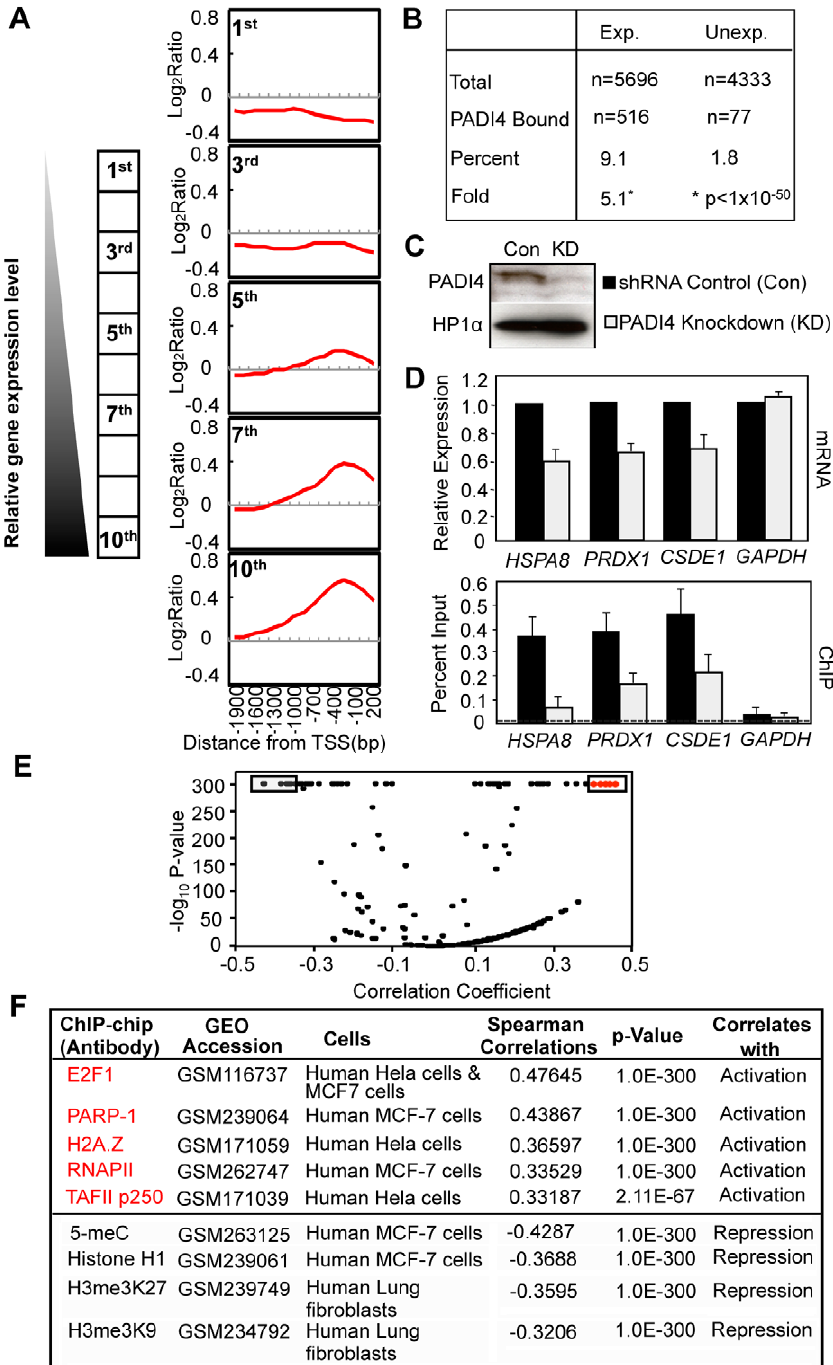
Figure 2. PADI4 recruitment at gene promoters correlates with the actively transcribed genes. (A) The average log 2 enrichment ratio from PADI4 ChIP-chip is displayed for the genes in the MCF-7 cell cDNA microarray by decile of expression level from lowest (1 st ) to highest (10 th ). (B) Percentage and fold enrichment of PADI4-bound expressed and unexpressed genes. (C) Western Blot showing the shRNA-mediated depletion of PADI4 in MCF-7 cells versus shRNA control knockdown cells. (D) Gene-specific analysis of mRNA expression by RT-qPCR and PADI4 promoter binding by ChIP-qPCR in shRNA control and PADI4 knockdown MCF-7 cells. Expression data are normalized to b -actin transcripts and the graph is mean + SEM. The non-specific binding in the ChIP assay is indicated by the horizontal dotted line. (E) Volcano plot of computational comparison of PADI4 ChIP-chip dataset with multiple published ChIP-chip datasets. The score of each correlation was defined as the negative of the log 10 of the p-value for the correlation. (F) PADI4 ChIP-chip is positively correlated with the ChIP-chips assayed by gene activating markers (in red) while negatively correlated with the ChIP-chips assayed by gene silencing markers (in black). The data shown here represent a subset of the data shown in Figure 2E.